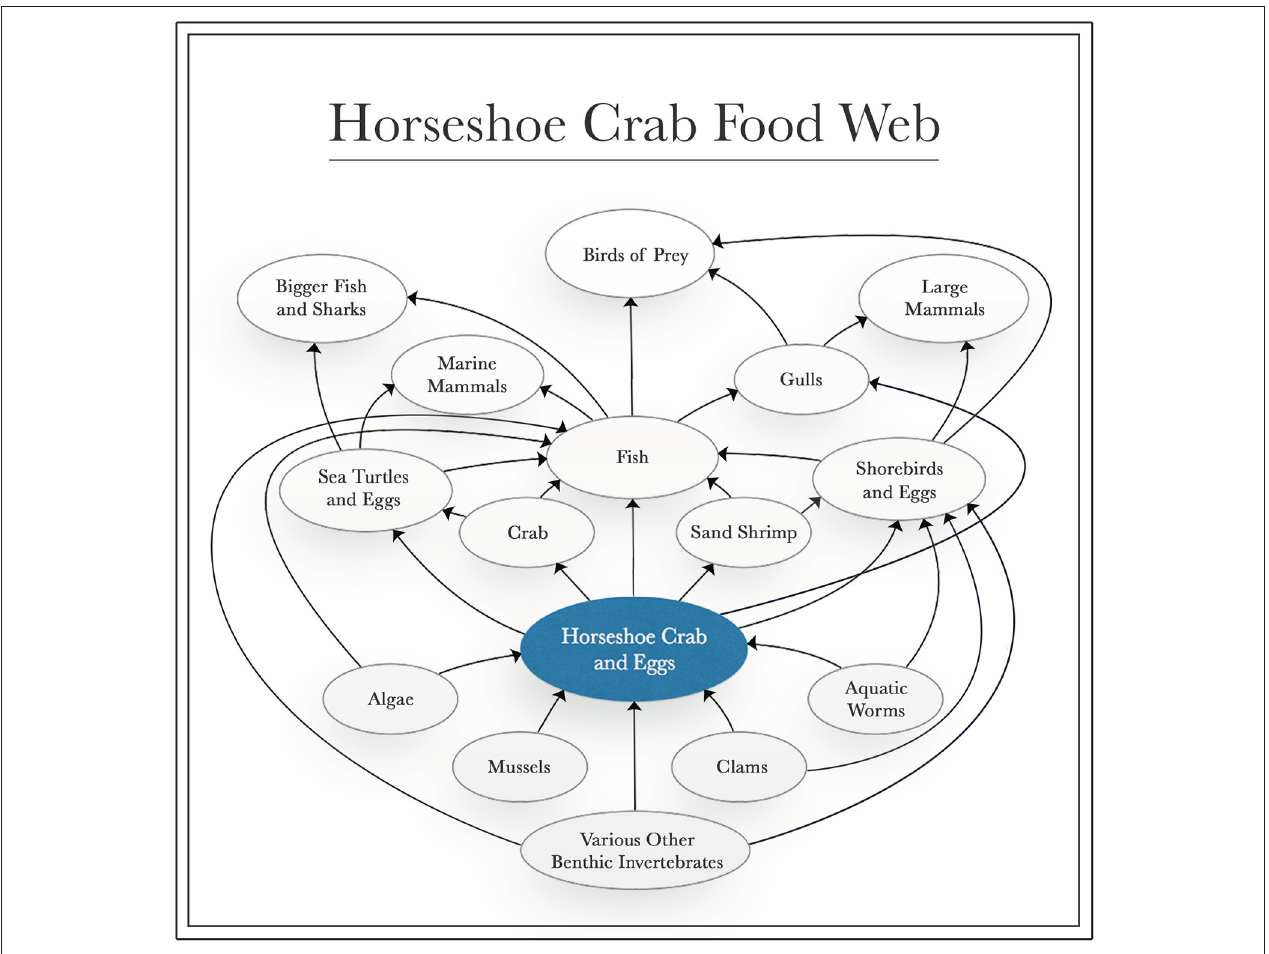
FIGURE 3 | Diagram of feeding interactions of the horseshoe crab. Directions of arrows indicate impacts of each group on others through feeding interactions.